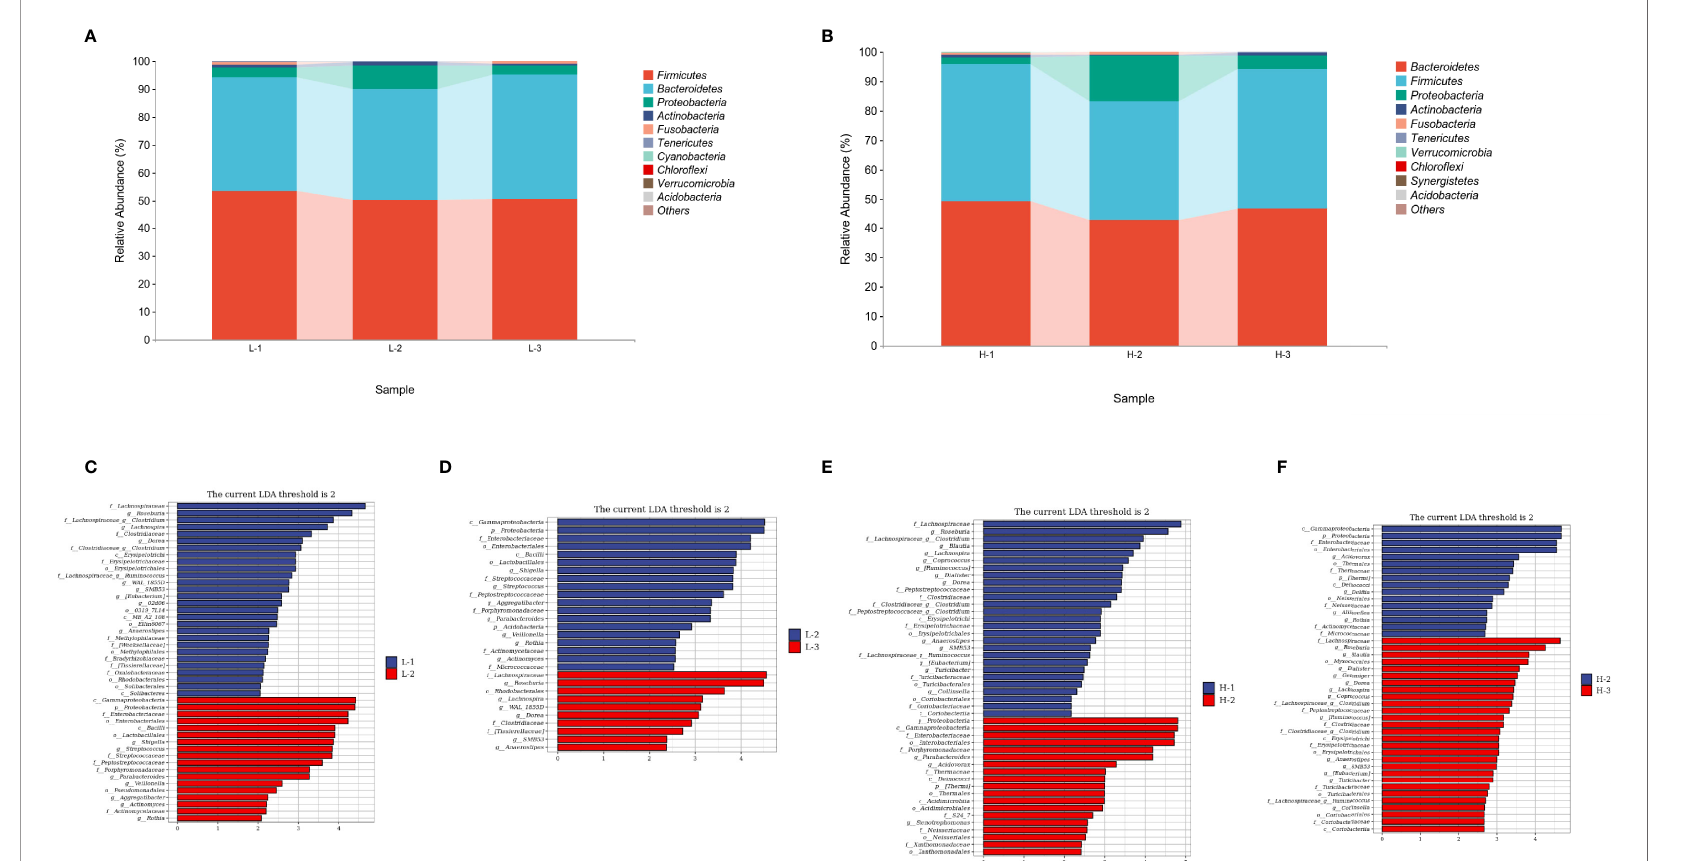
FIGURE 5 | Composition differences at the three time points in L-VA and H-VA therapy. The composition of the gut microbiota between L-VA (A) and H-VA (B) therapy at the phylum level (the abundance of Top 10 are shown). Differences in speci fi c bacterial taxa when comparing L-1 and L-2 (C) , L-2 and L-3 (D) , H-1 and H-2 (E) , and H-2 and H-3 (F) by LEfSe. L-1: the time point before eradication in the L-VA group; L-2: the time point after eradication in the L-VA group; L-3: the time point of con fi rmation in the L-VA group; H-1: the time point before eradication in the H-VA group; H-2: the time point after eradication in the H-VA group; H-3: the time point of con fi rmation in the H-VA